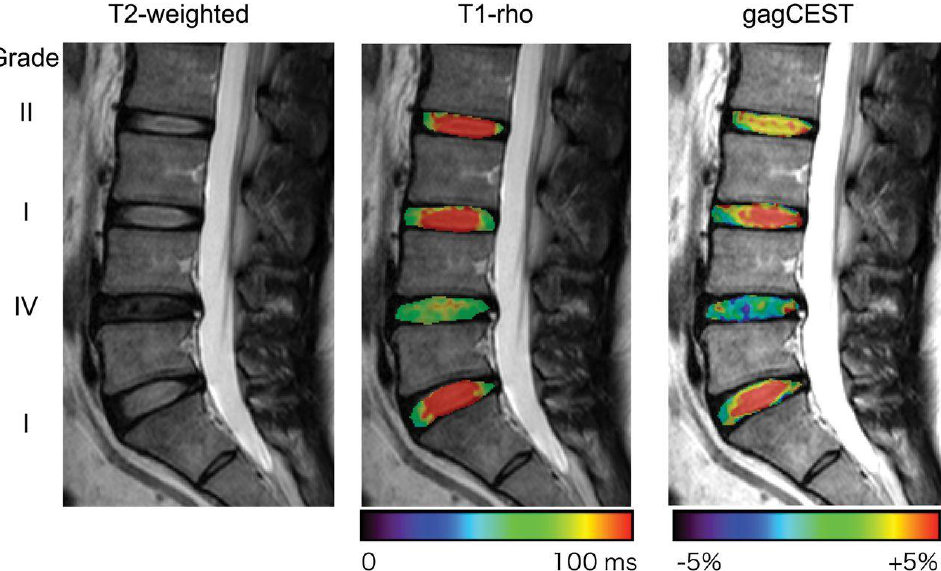
Figure 6. T1ρ mapping image and glycosaminoglycan chemical exchange saturation transfer (gagCEST) image (reused from [66]). The L4/5 disc, classified as Pfirrmann grade IV on T2WI, shows a shortened T1ρ and lower gagCEST signal intensity compared with the other discs without degeneration (Pfirrmann grade I or II).